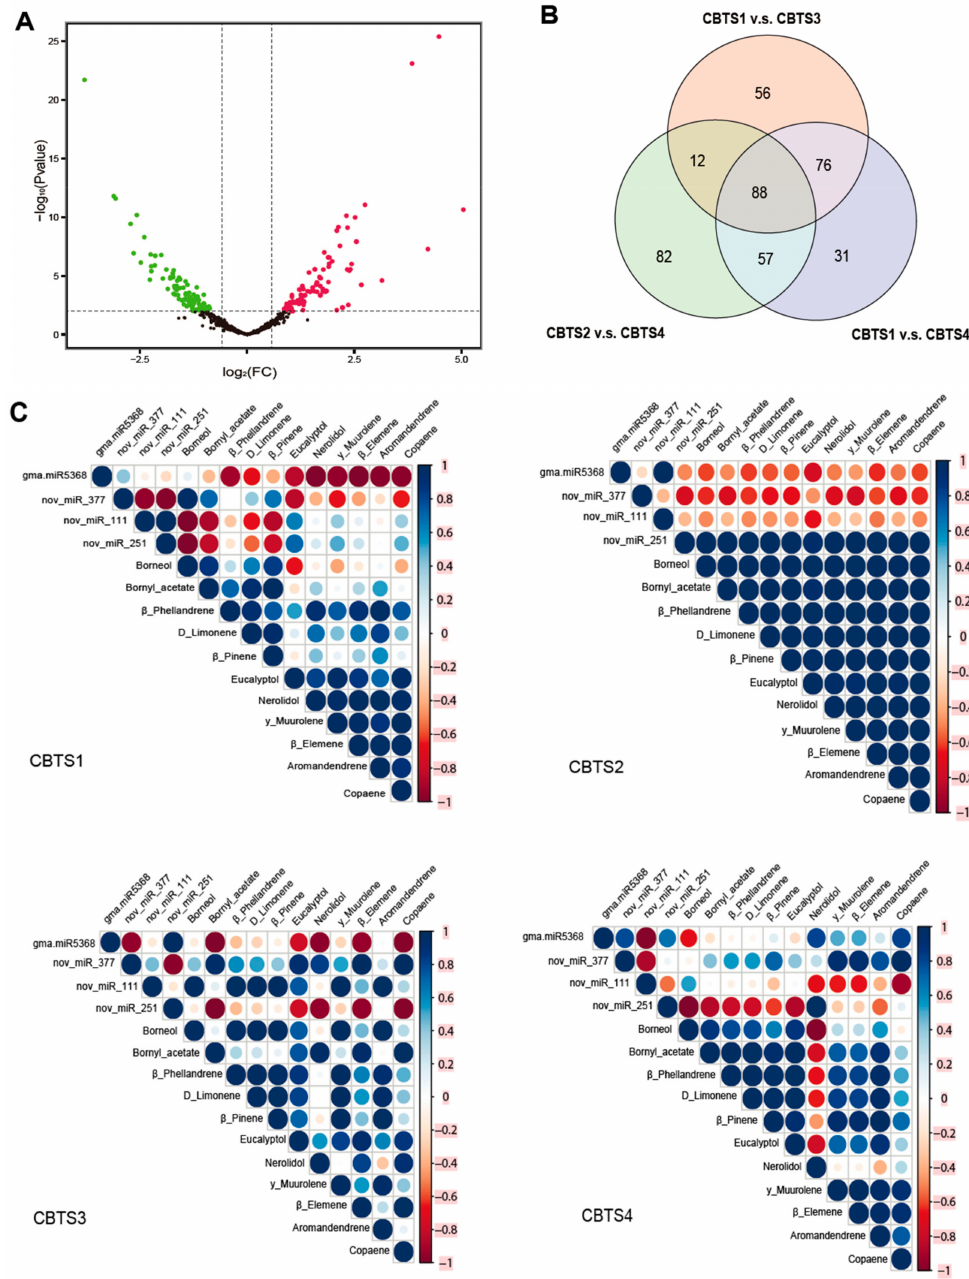
Figure 4. DEmiRNAs and co-expression analysis with terpenoids. ( A ) A volcano plot showing the number of DEmiRNAs between CBTS1 and CBTS4 in red (up-regulated genes) and green dots (down- regulated genes) and black dots represent the remaining non-differentially expressed miRNAs. ( B ) A Venn diagram showing the overlap in DEmiRNAs. ( C ) Correlation coefficient of miRNAs and six monoterpenoids (borneol, bornyl acetate, β -phellandrene, D-limonene, β -pinene, and eucalyptol) and five sesquiterpenoids (nerolidol, γ -muulrolene, β -elemene, aromandenrene, and copaene) evaluated by Pearson correlation analysis ( p -value < 0.05) across four developmental stages (CBTS1-S4) of C. burmannii